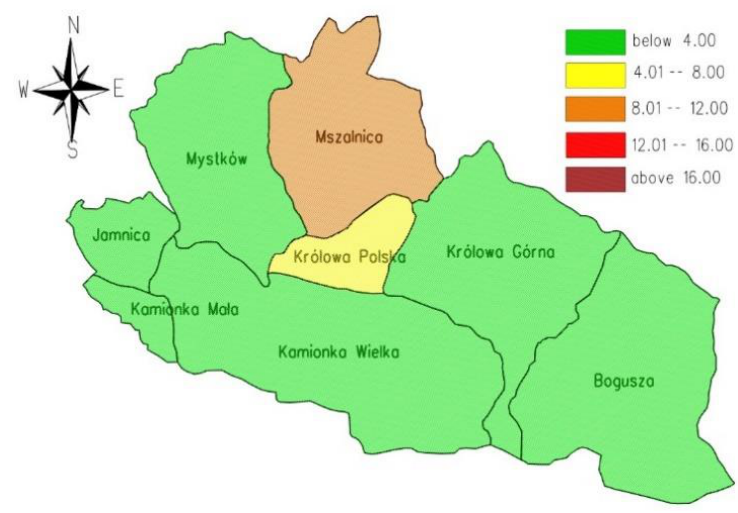
Figure 3. WIT 1 - agricultural activities for the municipality of Kamionka Wielka. Figure 3. WIT 1—agricultural activities for the municipality of Kamionka